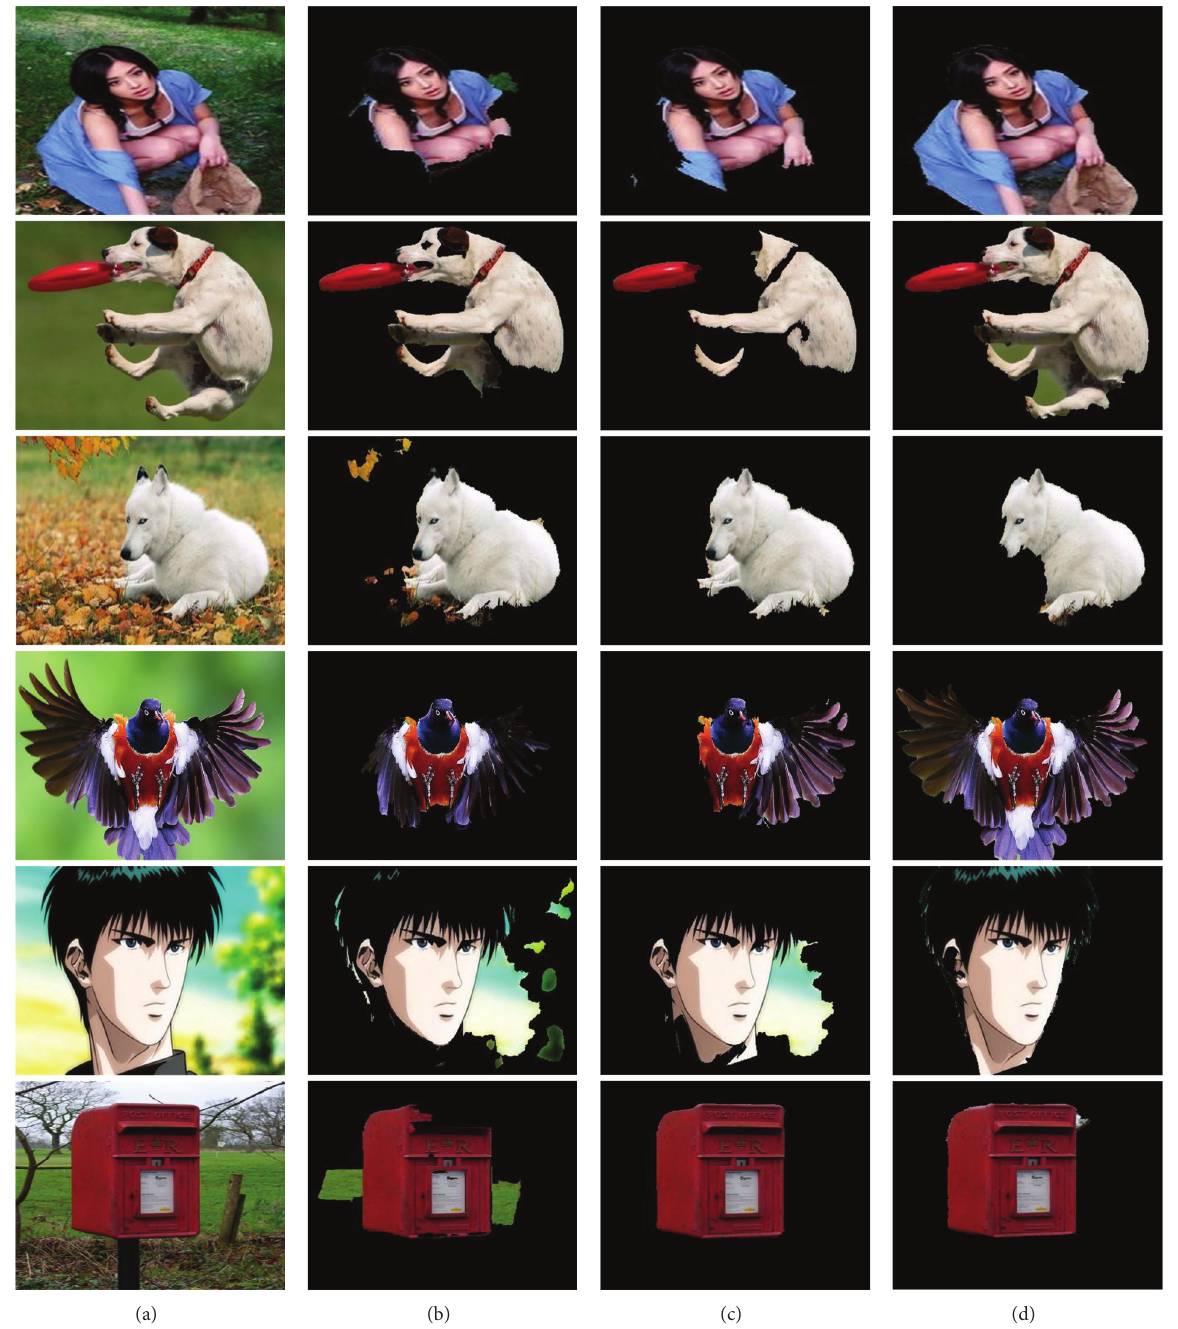
Figure 4: Results in the second data set. (a) Original images. (b) Foreground extracted with RC [13]. (c) Foreground extracted with TSS [14]. (d) Foreground extracted with